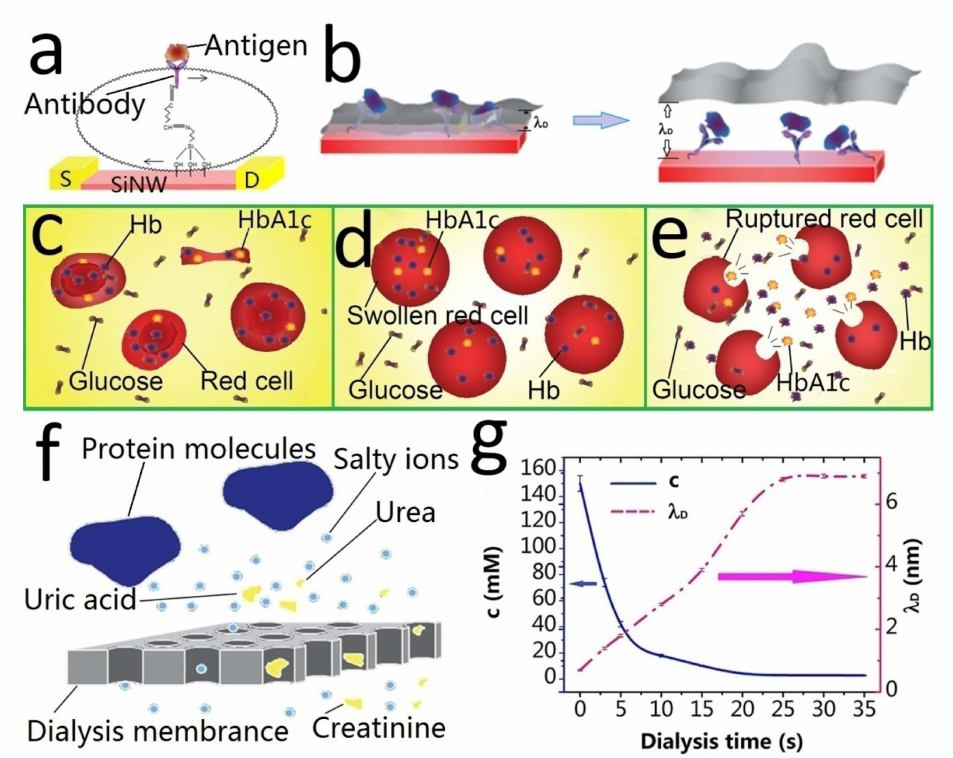
Figure 4. Principle of the Debye shielding effect and microdialyzer. ( a ) Schematic diagram of the electric field effect generated by antigen molecules during detection. ( b ) Schematic diagram of Debye length and Debye shielding effect. ( c – e ) Schematic diagram of the stepwise hemolysis process. ( f ) Principle of the dialysis membrane. ( g ) Ionic strength and Debye length of the solution during dialysis as a function of dialysis